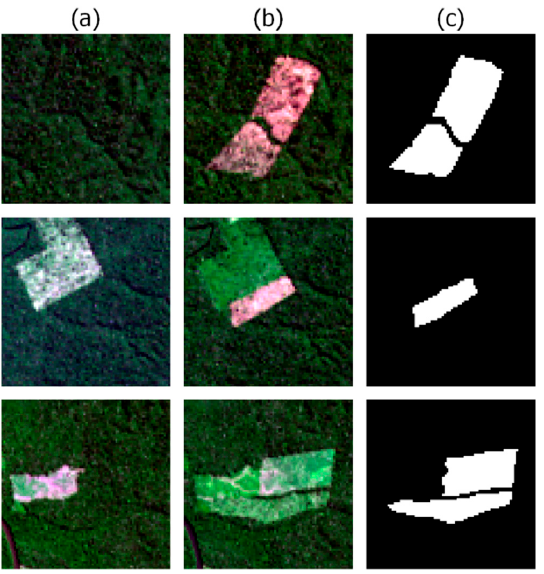
Figure 4. Example of the change mapping in three locations between ( a ) 2017 and ( b ) 2018 and the respective ( c ) rasterized deforestation mask.